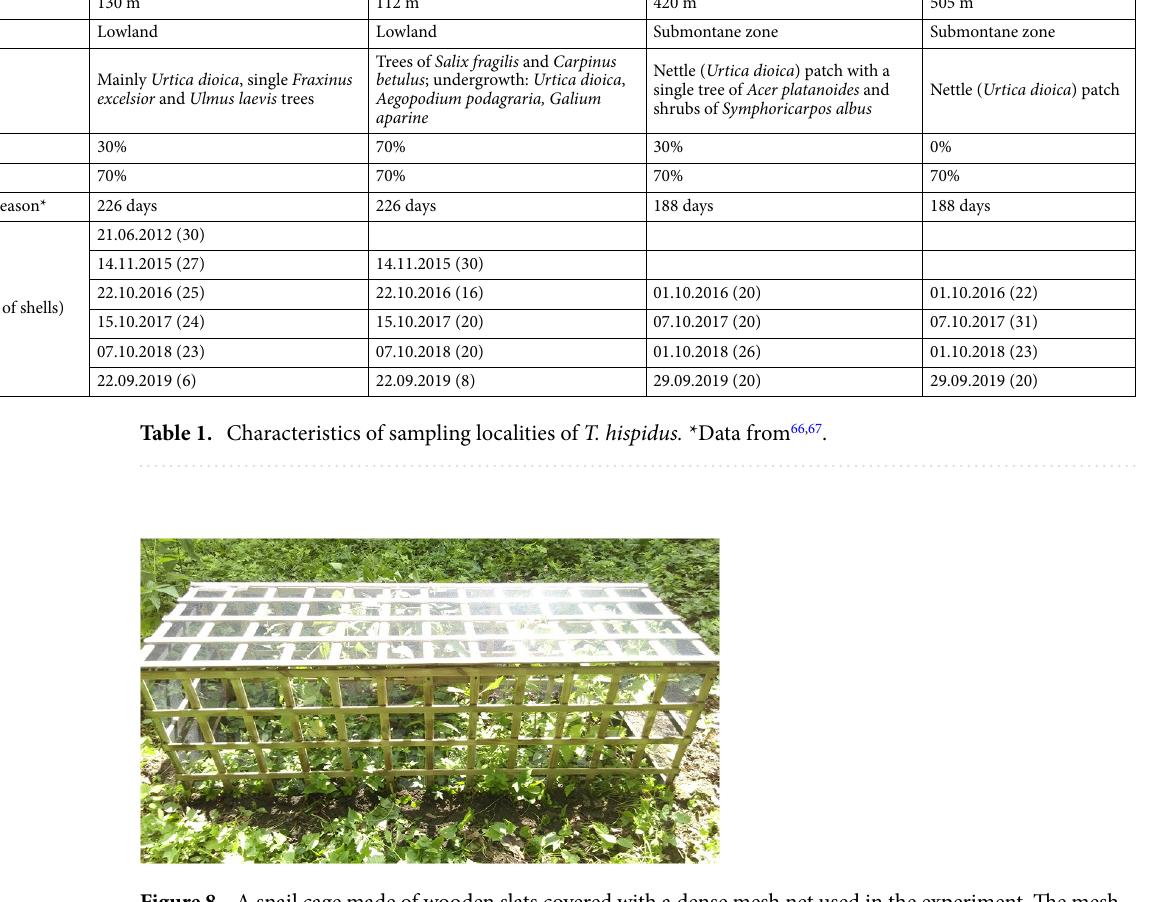
Figure 8. A snail cage made of wooden slats covered with a dense mesh net used in the experiment. The mesh size is ca. 1.5 mm to prevent snails